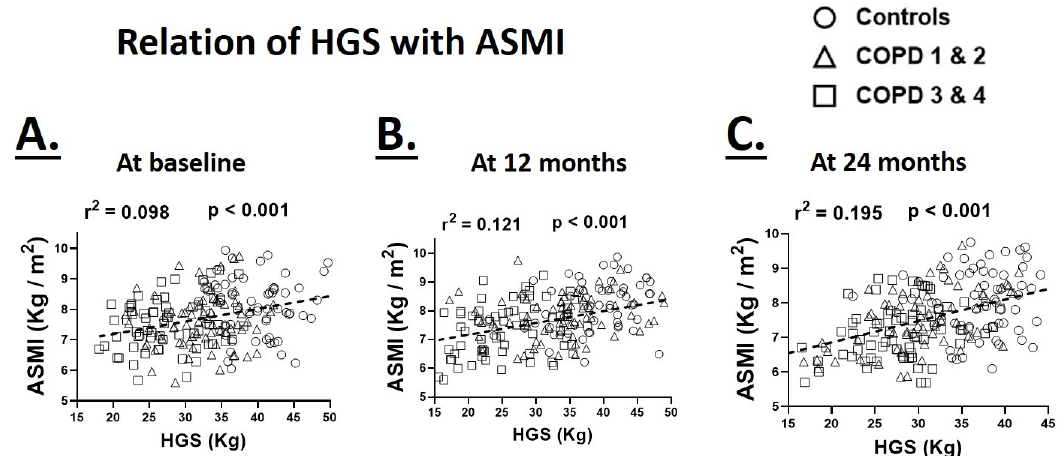
Figure 3. Relationship of hand-grip strength (HGS) with appendicular skeletal muscle mass (ASMI) at the baseline ( A ), 12 ( B ) and 24-month ( C ) time points in healthy controls and patients with COPD GOLD stages 1 and 2 and 3 and 4 ( n = 64–68 participants/group/time point for pooled data).